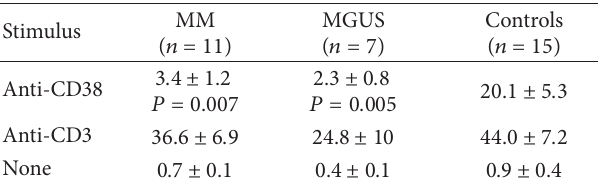
Table 2: Altered response in IFN 𝛾 and IL-6 cytokine release upon CD38 ligation in MM patients.